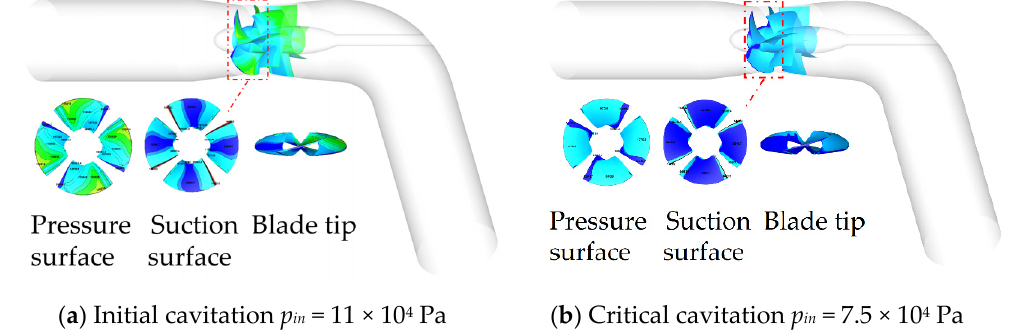
Figure 16. Flow condition Q = 411 L/s pressure distribution cloud diagrams.